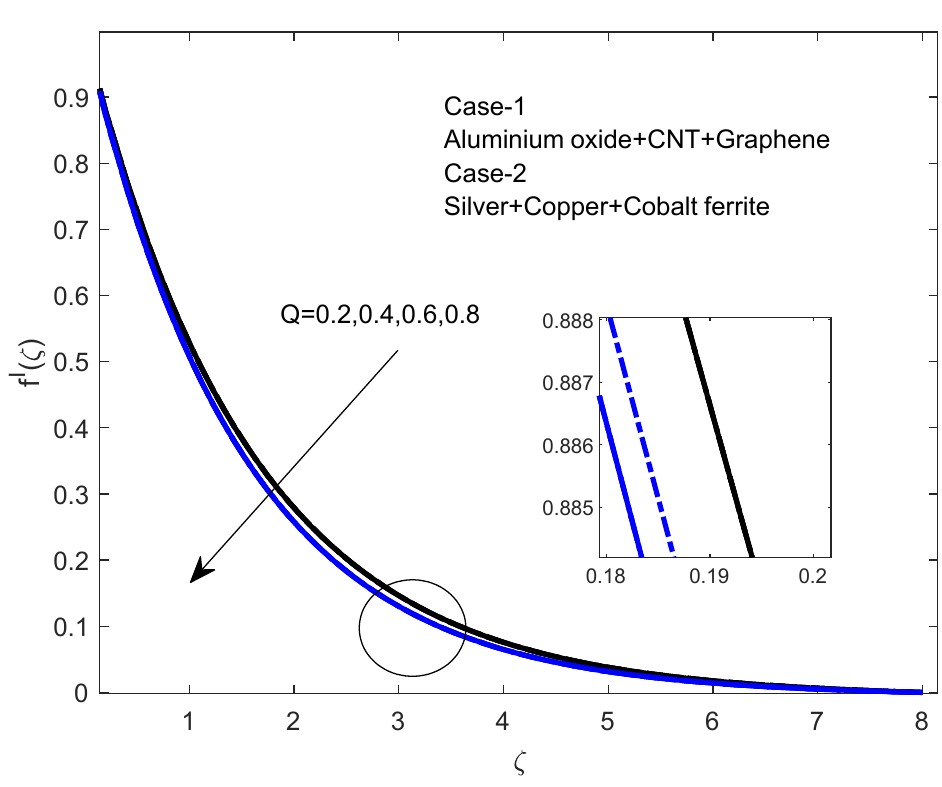
Figure 9. The effect of Q on the velocity profile.